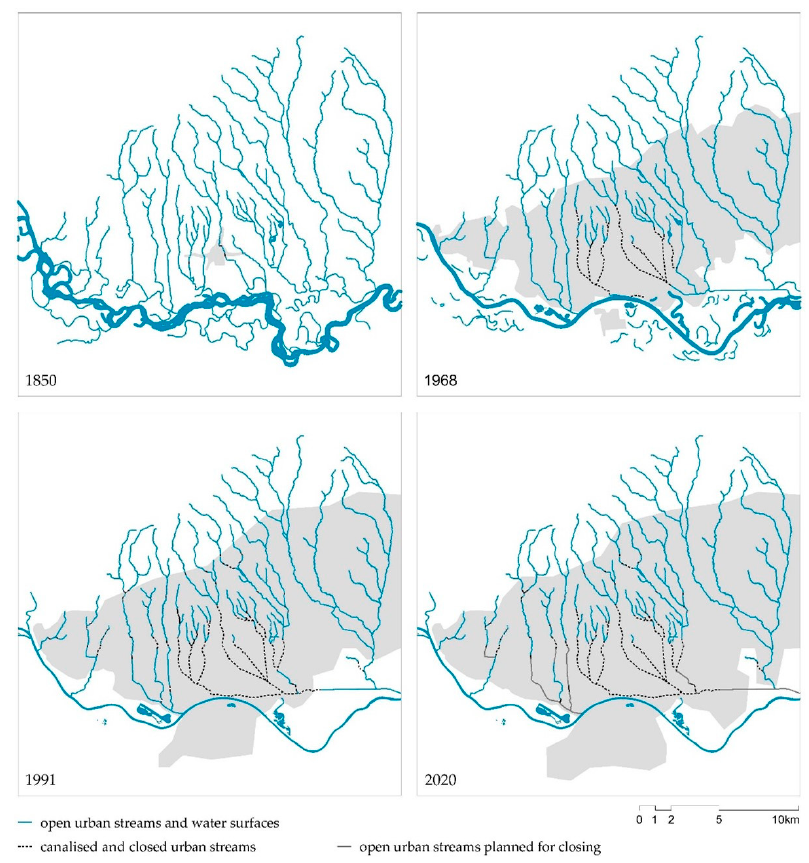
Figure 2. The genesis of the Zagreb stream system. Source: Authors.